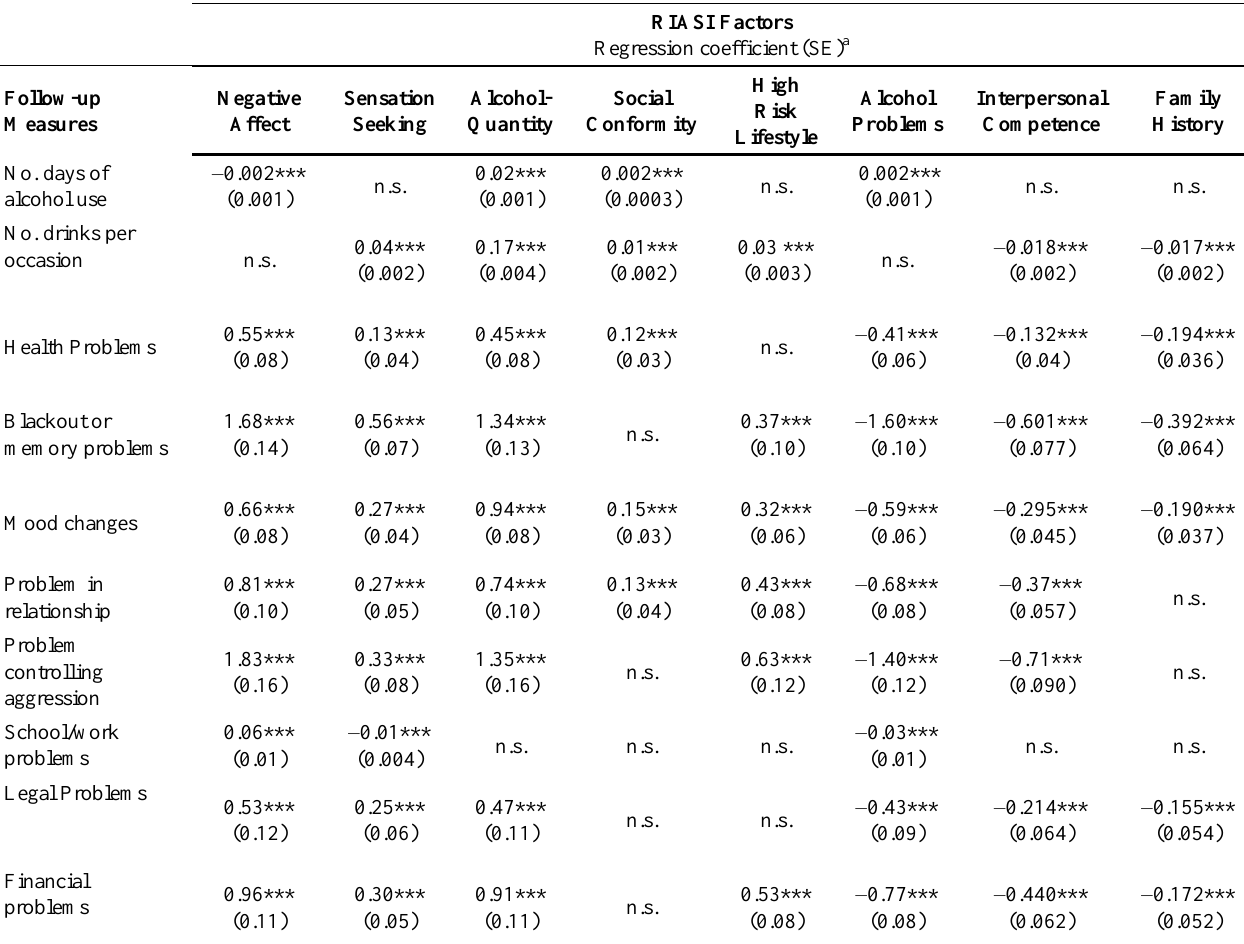
Table 3. Association between RIASI factors and measures obtained in the follow-up period. Back on Track remedial program clients (N =